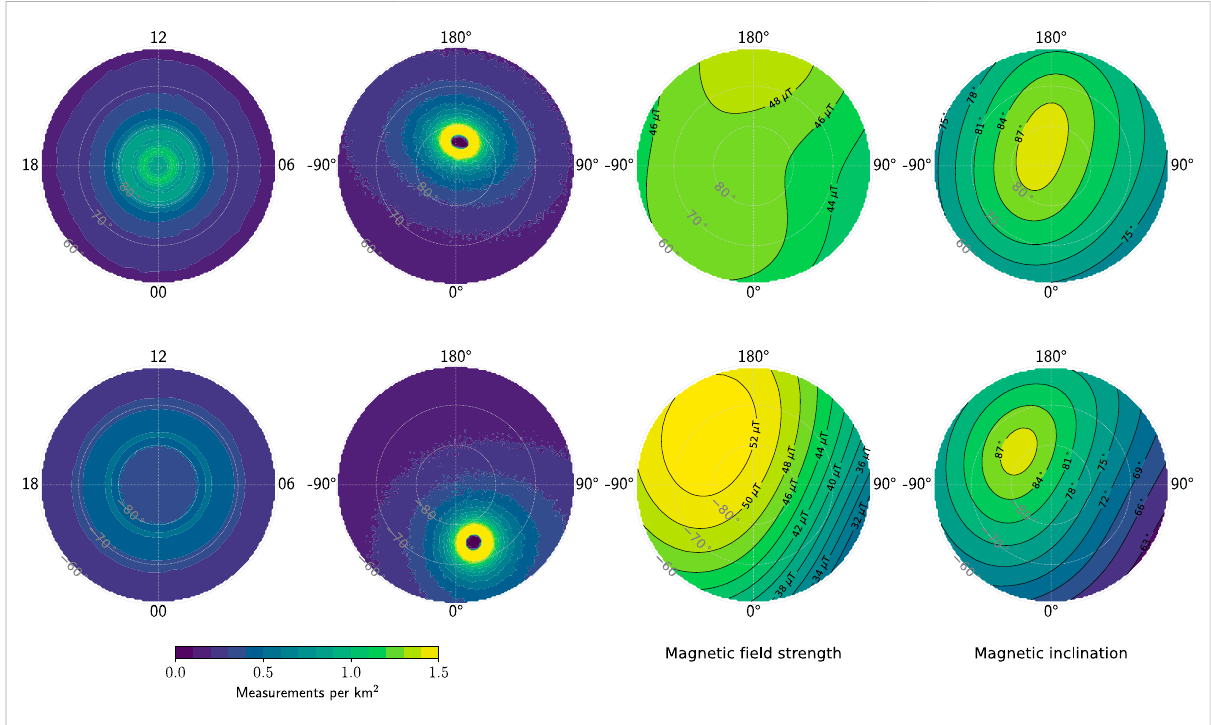
FIGURE 11 Color plots of the distributions of data points used to make the AMPS model in the Northern and Southern Hemisphere (top and bottom row, respectively), shown on a magnetic latitude-local time grid (column one) and magnetic latitude-longitude grid (column two). Also shown are the magnetic fi eld strength (column three) and the inclination angle (column four), evaluated at 450-km altitude using the IGRF